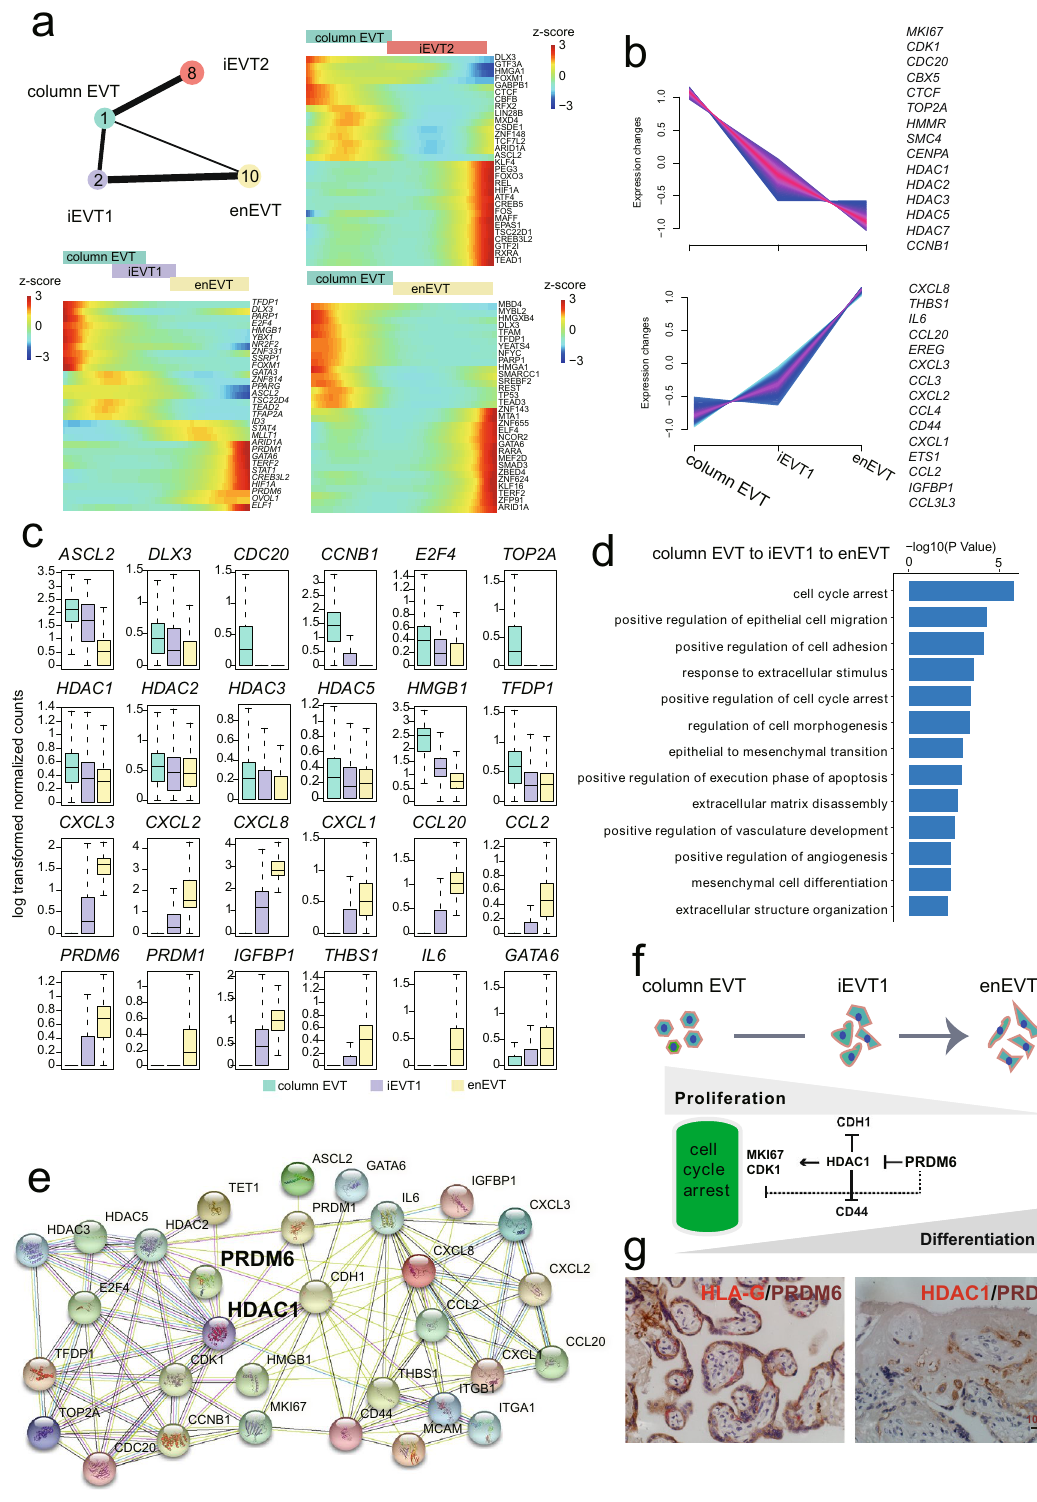
Figure 4. Identification of key transcription factor (TFs) regulators during extravillous trophoblast cell differentiation. ( a ) Partition- based approximate graph abstraction (PAGA) analysis of EVT subpopulations, including column trophoblast cell (column EVT), interstitial extravillous trophoblast cells 1/2 (iEVT1/2), and endovascular extravillous trophoblast cells (enEVT). Lines show connections; line thickness corresponds to the level of connectivity (low (thin) to high (thick) PAGA connectivity). Heatmap showing min–max normalized expression of statistically significant (P < 0.001), dynamically variable TFs from pseudotime analysis for EVT trajectories. ( b ) The expression pattern of selected DEGs of column EVT, iEVT1 and enEVT. ( c ) Boxplot visualization of log- transformed, normalized expression of selected TFs in EVT subgroups. ( d ) Selected Gene Ontology (GO) terms of TFs differentially expressed in column EVT, iEVT1 and enEVT, respectively. ( e ) STRING database for the regulatory network analysis of selected TFs differentially expressed in column EVT, iEVT1 and enEVT. ( f ) Model of regulation loops of column EVT differentiation into enEVT. ( g ) Immunostaining of HLA-G, PRDM6 and HDAC1 in Mat_S of human full-term placenta. Scale bar represents 100